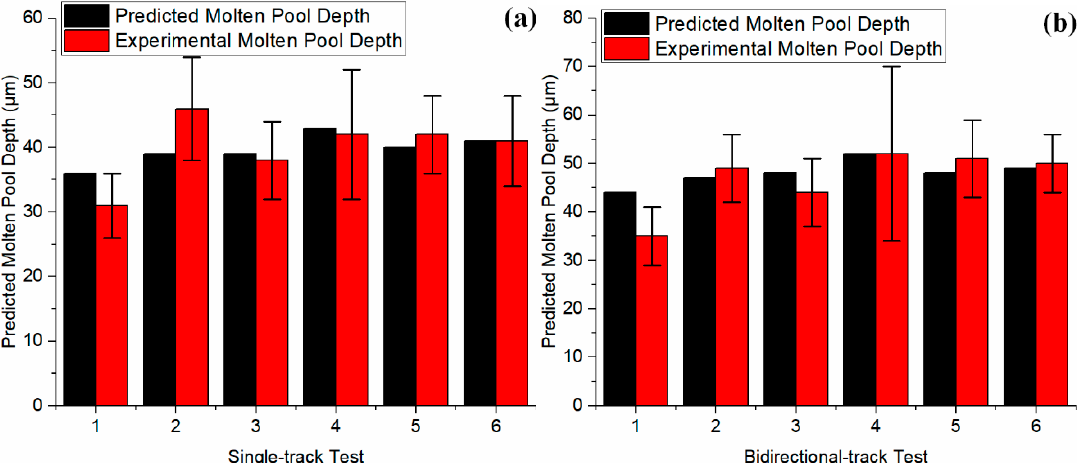
Figure 8. Validation of predicted molten pool depth in ( a ) a single track scan and ( b ) a bidirectional scan after stabilization. Black color represents predicted melt depth. Red color represents experimental melt depth based on solidified microstructure. The determined absorption of 40% was used in the predictions.